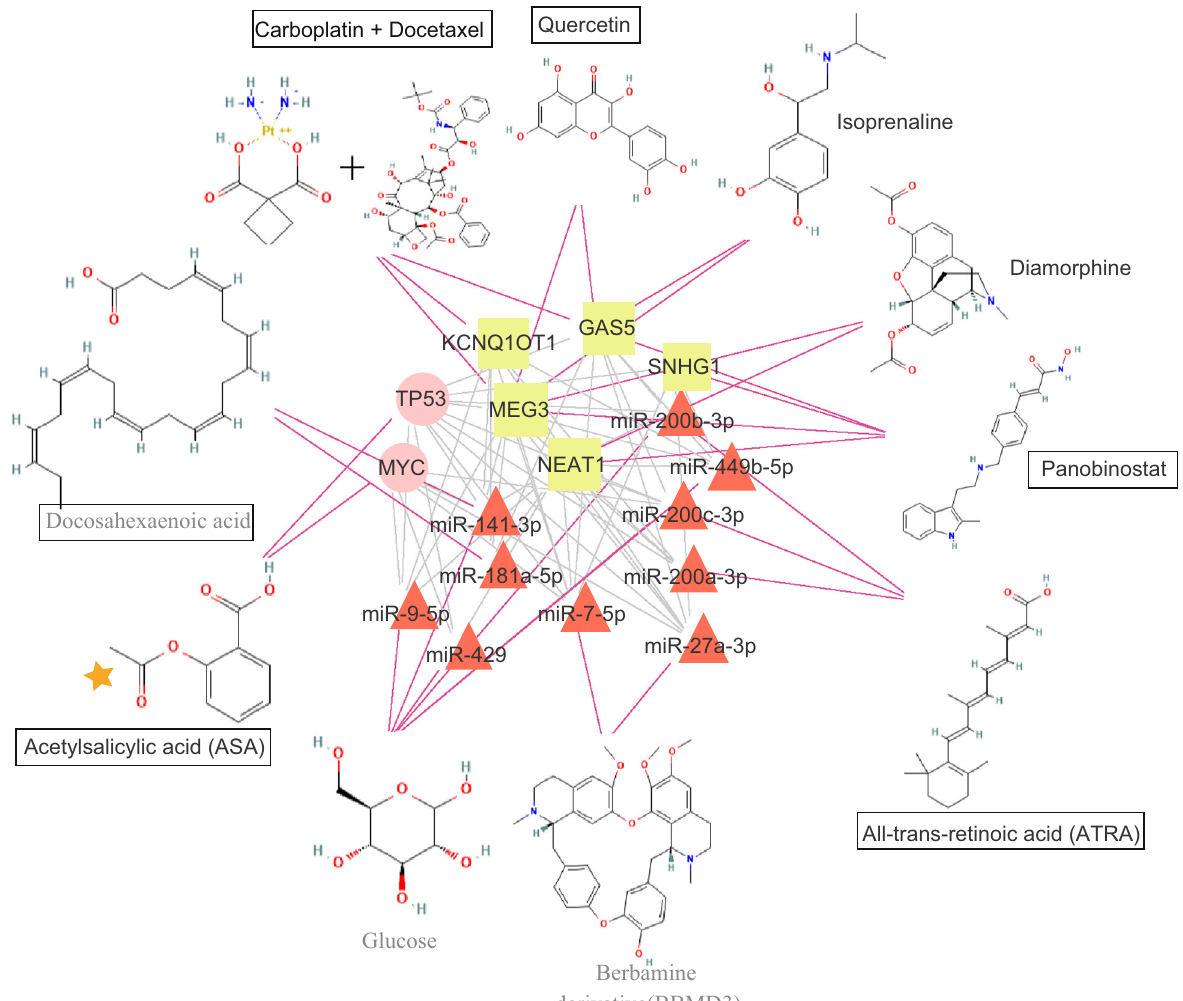
Fig. 6 Drug repositioning prediction of high-con fi dence susceptibility